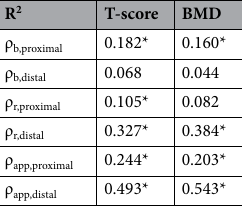
Table 1. R 2 values of linear regression analysis by plotting each measured density values over T-score and BMD. Significant models are marked with *.